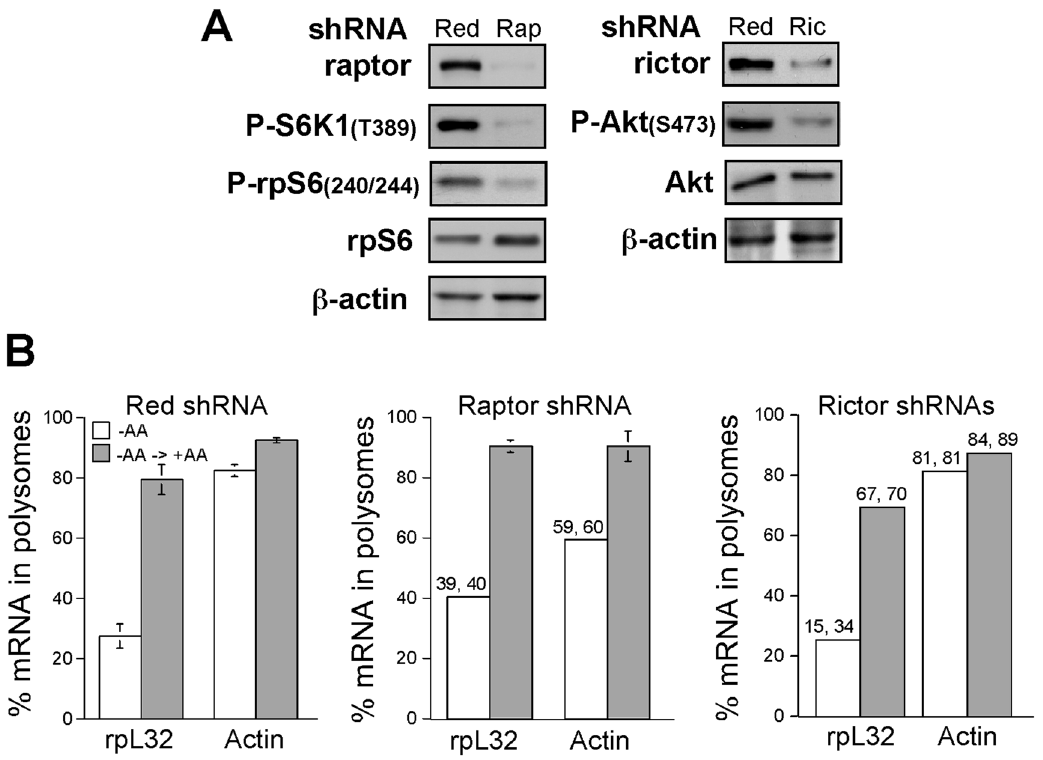
Figure 3. Raptor and rictor are dispensable for translational activation of TOP mRNAs by amino acids. (A) HEK293 cells were infected with viruses expressing Red shRNA, raptor shRNA (Rap) or rictor shRNAs (Ric). The abundance of raptor or rictor, as well the phosphorylation status of direct and indirect substrates of the respective complexes, mTORC1 and mTORC2 (left and right, respectively), was monitored by Western blot analysis. (B) HEK293 cells infected with viruses expressing HcRed, raptor or rictor shRNA were amino acid starved for 3 h ( 2 AA) or starved and then refed for 3 h ( 2 AA R + AA). Cytoplasmic extracts from these cells were subjected to polysomal analysis and the data are presented as described in the legend to Fig. 2F. Numbers above bars are individual values, when only two measurements were